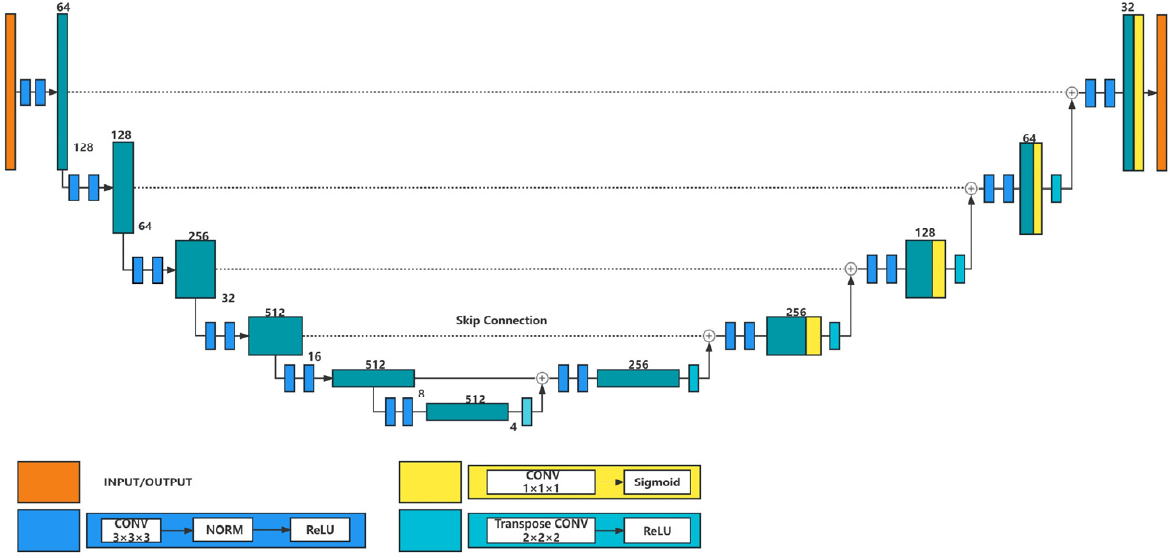
Figure 1. Overall explainable framework of brain tumor detection. The three parts of the framework include: segmentation, classification, and explainability.